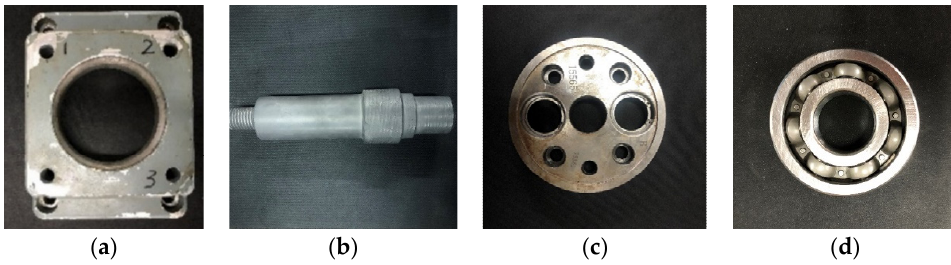
Figure 9. Scanned objects: ( a ) object 1; ( b ) object 2; ( c ) object 3; ( d ) object 4.